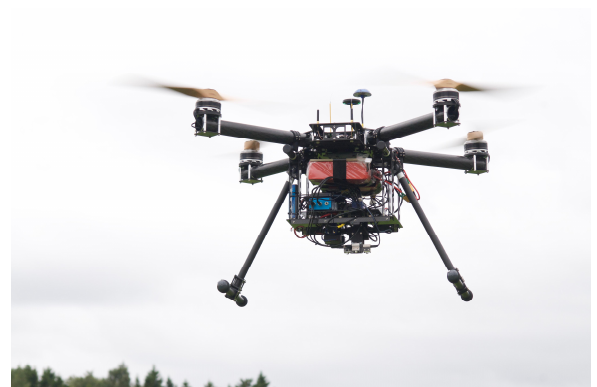
Figure 16 DroneKnowledge hyperspectral imaging system airborne with the Avartek drone.